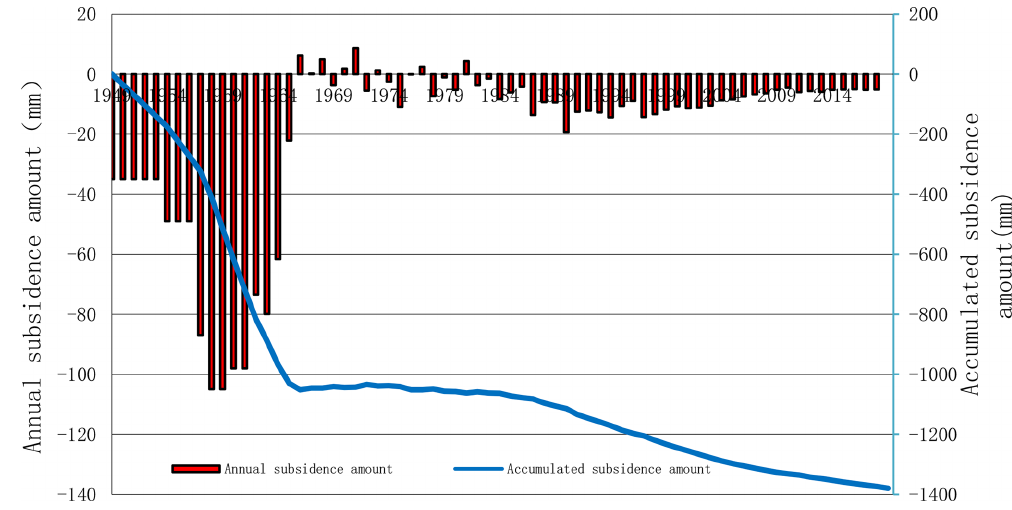
Figure 1. Land subsidence development duration characteristic curve in Shanghai.